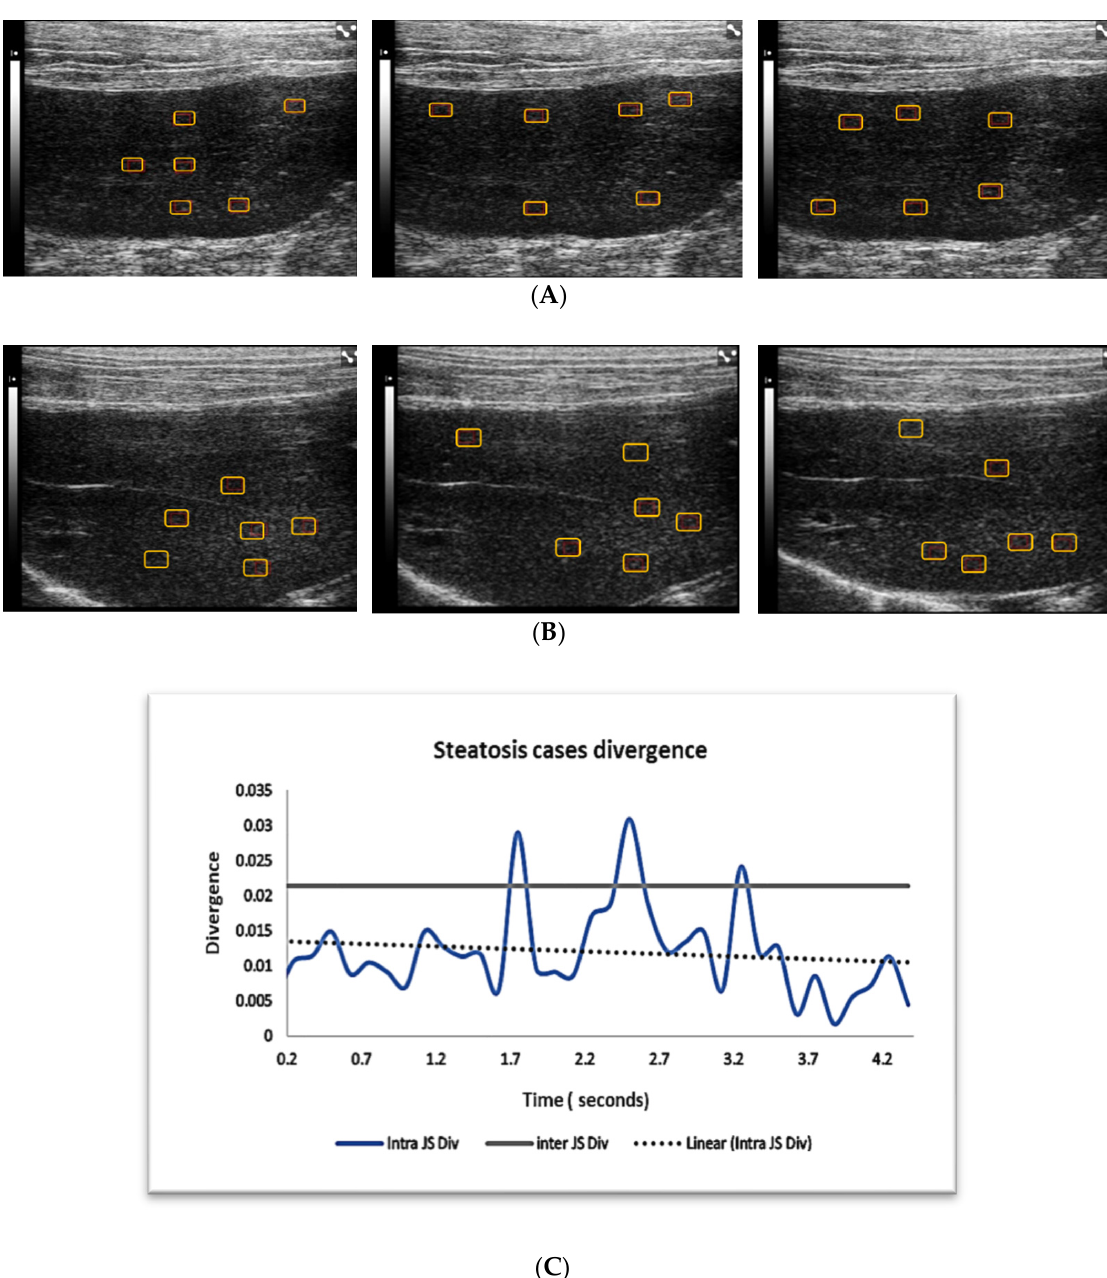
Figure 4. Panels ( A , B ) show examples of B-mode ultrasound liver images from two steatosis cases. Panel ( A ) shows three sequential images from the same case with region of interests (ROIs) for quantitative analysis. Panel ( B ) shows three sequential images from a second steatosis case. Panel ( C ) displays the intra- and intercase JS divergence for steatosis cases in general. Intra- and intercase divergence for steatosis cases is far apart, indicating that we cannot claim independence of intrasam- pling in these cases. Five to six regions of interests are placed (red rectangular boxes) on each image for quantitative analysis.